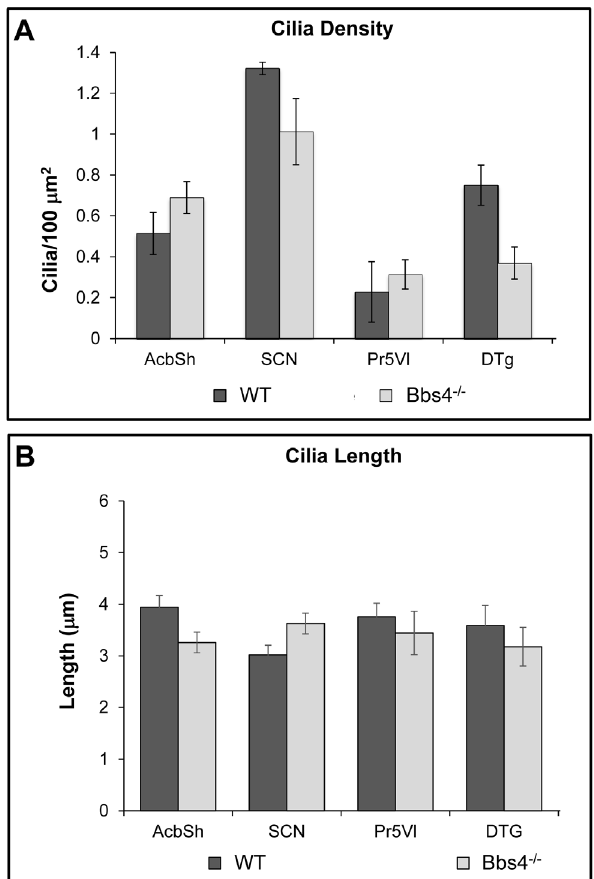
Figure 8. Statistical analysis of brain regions not affected by the syndrome compared to the corresponding areas in WT mice: cilia length ± the SEM (A) and cilia density ± the SEM (B) within each of the analyzed brain regions of WT (dark gray) and Bbs4 -/- (light gray) mice. Abbreviations as for Figure 6. The data for (A) and (B) was collected from three WT and five Bbs4 -/- mice.